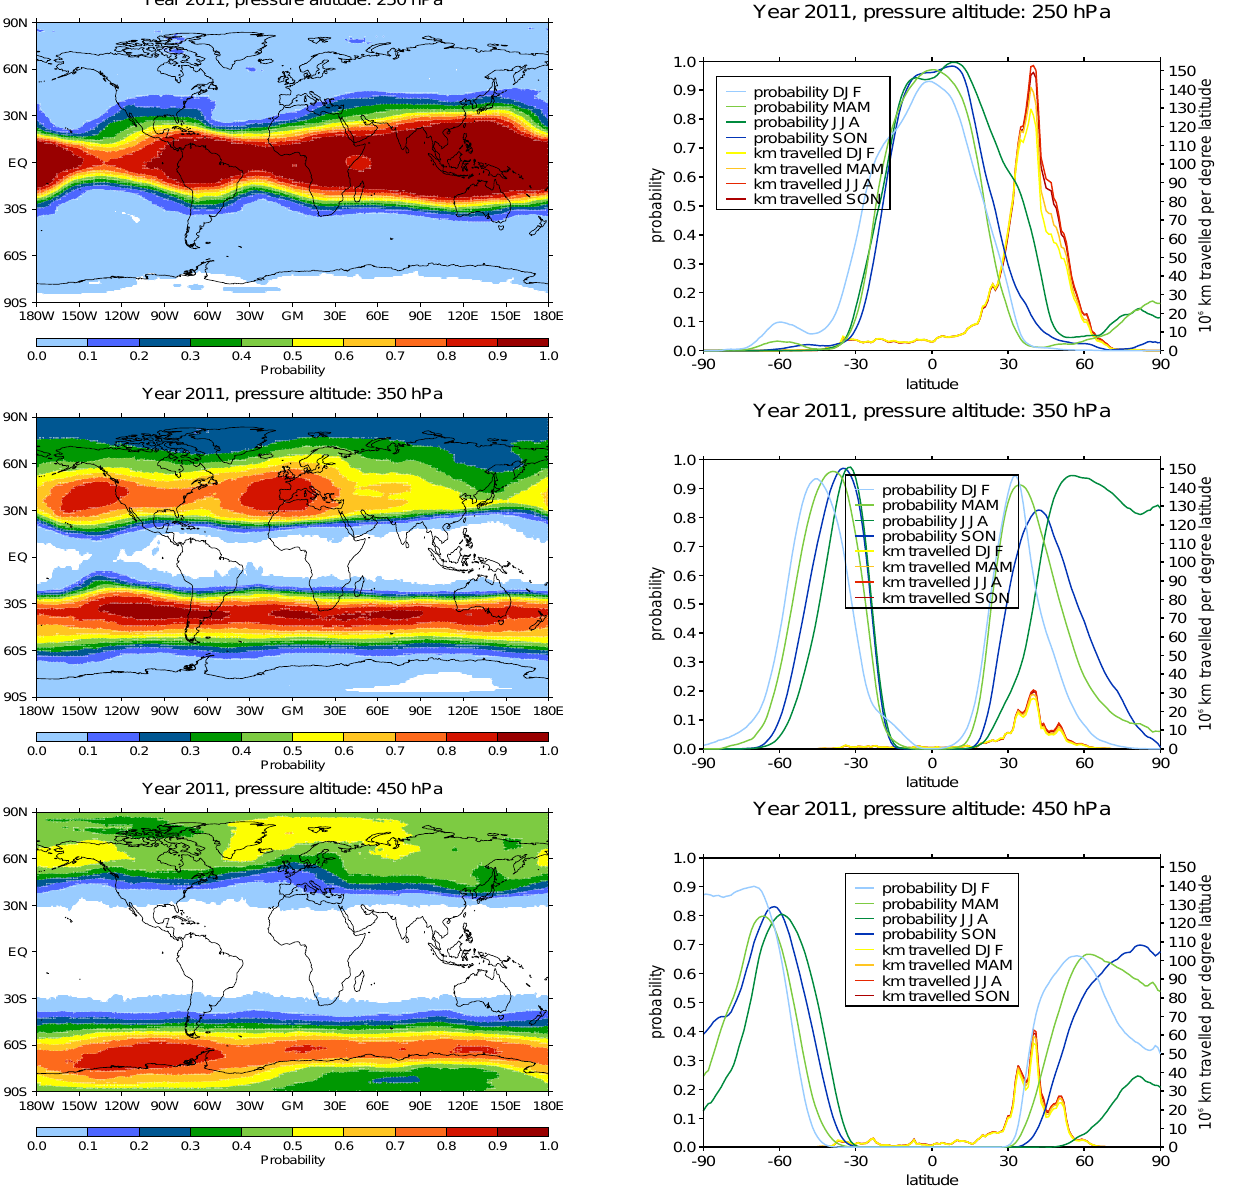
Fig. 4. Global distribution of regions that are conditioned to formation of aerodynamic contrails in 2011 for three pressure levels, 250, 350, and 450 hPa (from top to bottom). Only temperature criteria are considered for this figure.